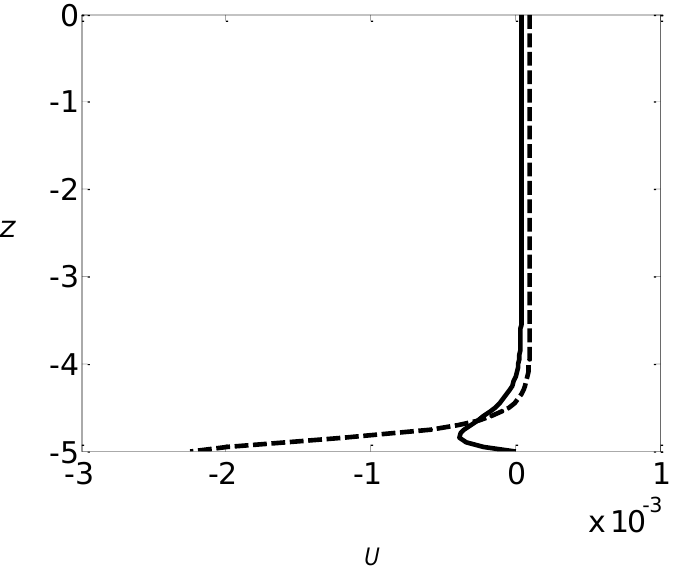
Figure 6. Horizontal velocity profiles for the full (solid line) and pure vegetative drag balance (dashed line) solutions at t = 1.25 and z =